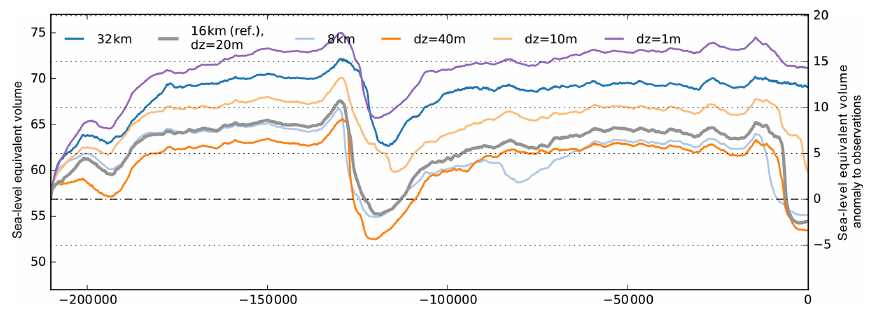
Figure 5. Ice volume above flotation for simulations with horizontal reference resolution of 16km (grey), fine grid resolution of 8km (light blue) and relatively coarse resolution of 32km (blue), resulting in different Antarctic Ice Sheet histories. Refined vertical resolution of 10m (light orange) and 1m (violet) at the base yields larger ice volumes than the reference simulation with 20m resolution (grey) or for coarse resolution of 40m (orange).